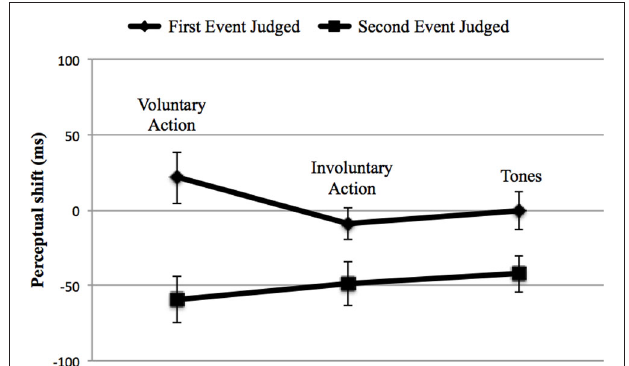
FIGURE 5 | Children’ perceptual shifts in the three main context: Voluntary Action, Involuntary Action and Tones (i.e., the two auditory stimuli context: Tone 2–Tone 1) . Error bars represent SEM. The first event judged ( (cid:7) ) could be either the voluntary action, the involuntary action or the Tone 2. The second event judged ( (cid:4) ) was always represented by Tone 1. Negative perceptual shifts indicate than an event is perceived earlier in an experimental condition than in the baseline condition; positive perceptual shifts indicate that an event is perceived later in an experimental condition than in the baseline condition. No temporal compression occurred for the voluntary